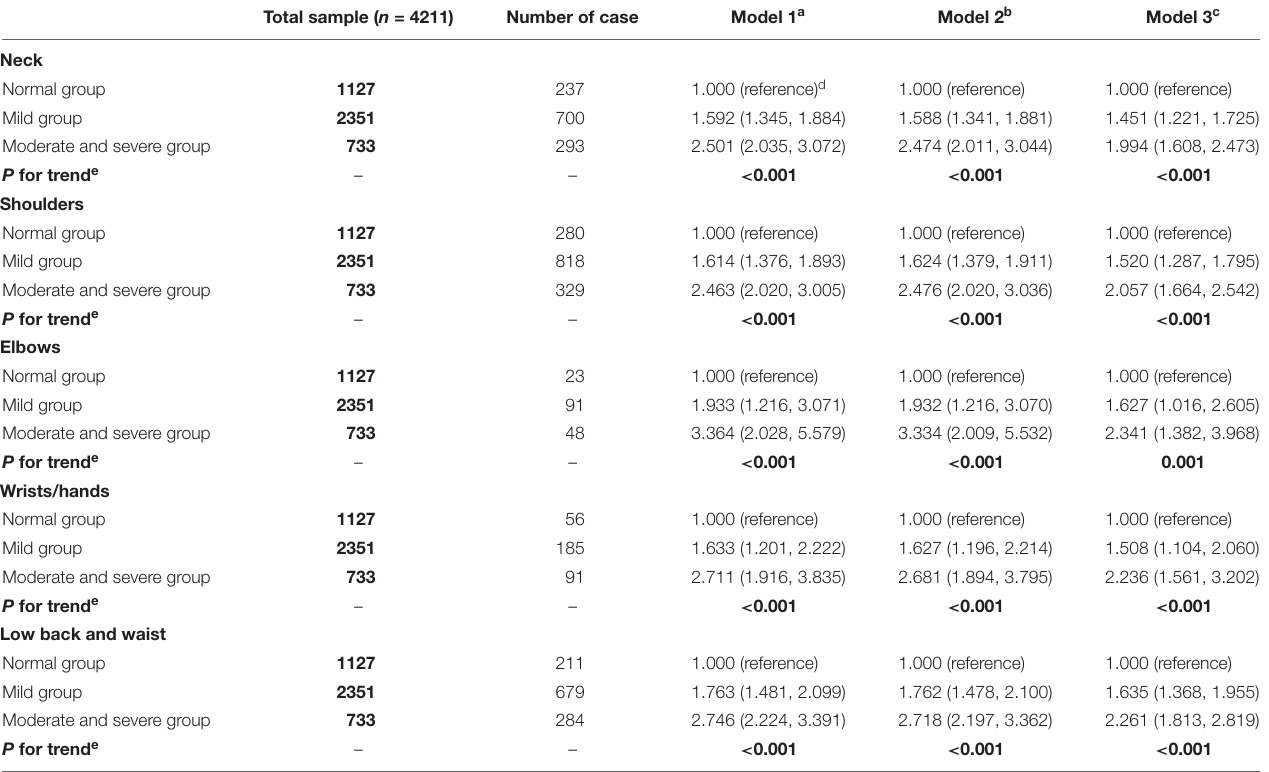
TABLE 2 | Adjusted relationships between IA and the risk of musculoskeletal discomfort in different body